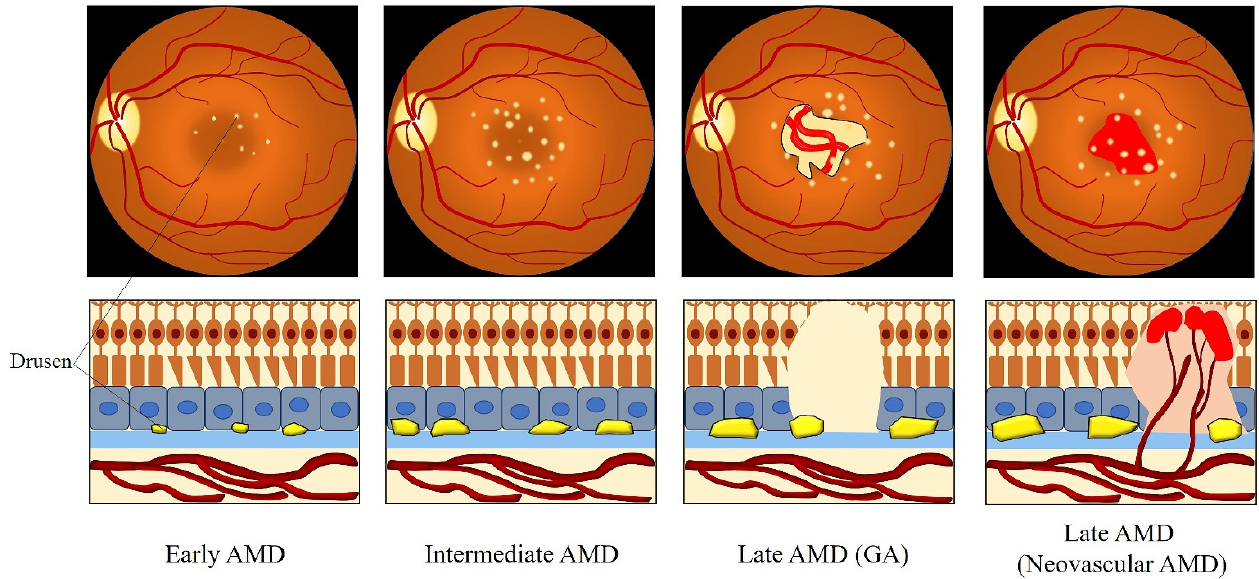
Figure 2. Clinical manifestation and pathology of AMD from the early to late stage. Medium-sized drusen found in early AMD. Intermediate AMD shows the presence of large drusen. Late AMD is classified into GA and neovascular AMD. GA is defined by the deterioration of the RPE, photoreceptor layer, and choroidal capillaries in the macula. The invasion of abnormal fragile choroidal blood vessels growing from the choroid into the retina in neovascular AMD, with blood and fluid leakage. Abbreviations: AMD: age-related macular degeneration; GA: geographic